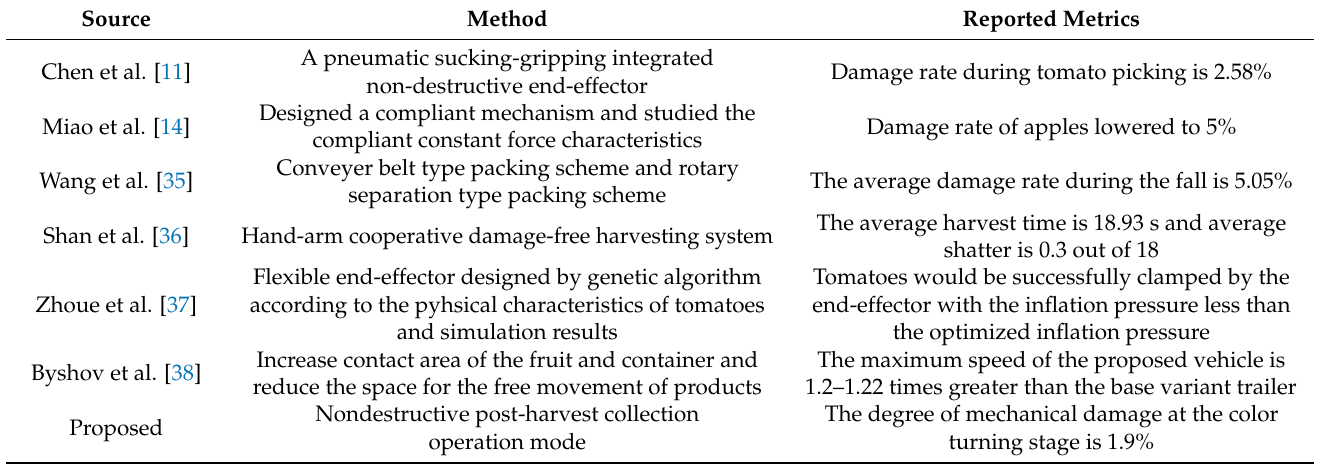
Table 4. Scientific studies in tomato nondestructive picking.